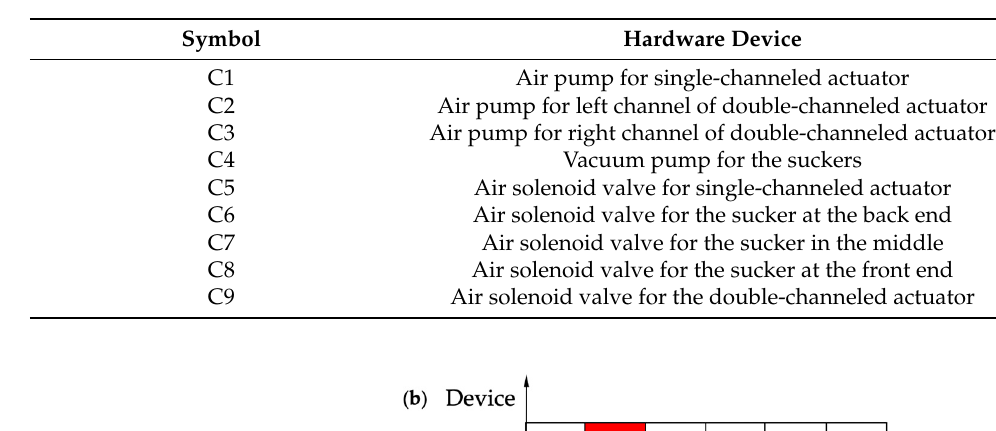
Table 1. The symbols for the different hardware devices.